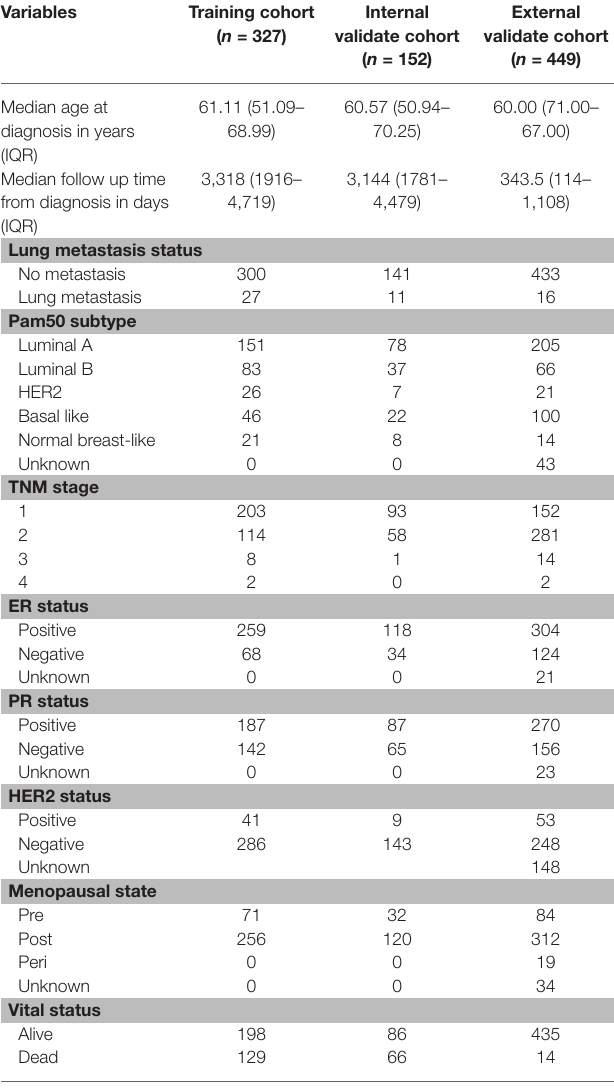
TABLE 1 | Demographics of the samples chosen for the